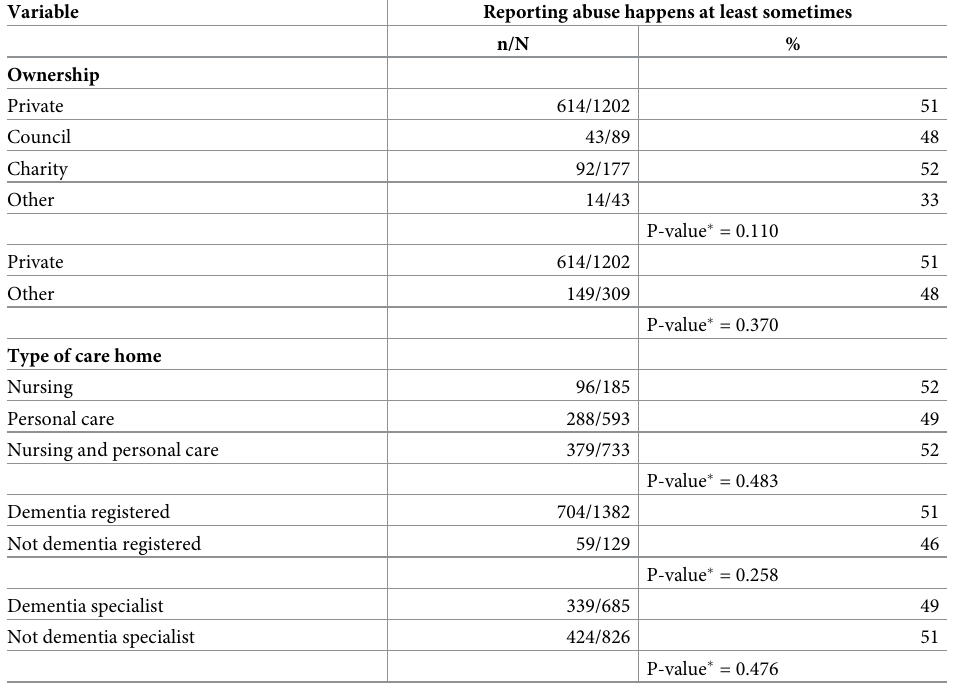
Table 2. Proportion of care staff reporting abusive behaviour at least sometimes by care home